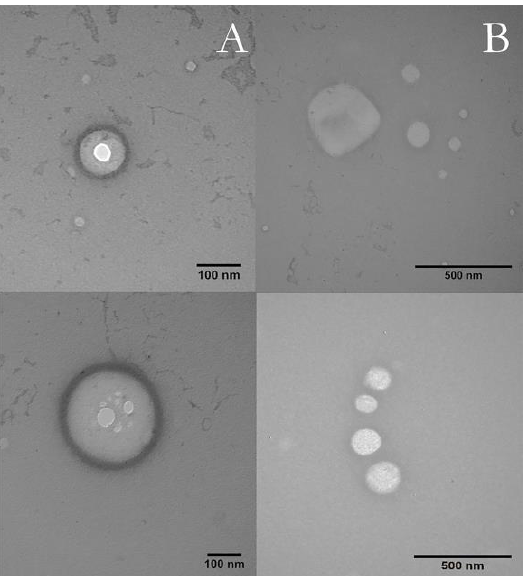
Figure 2. TEM micrographs (60 kV) of F5 (above) and F5 loading 2% indomethacin (F5-INDO) (below), at magnifications of 100,000× ( A ) and 60,000× ( B ).